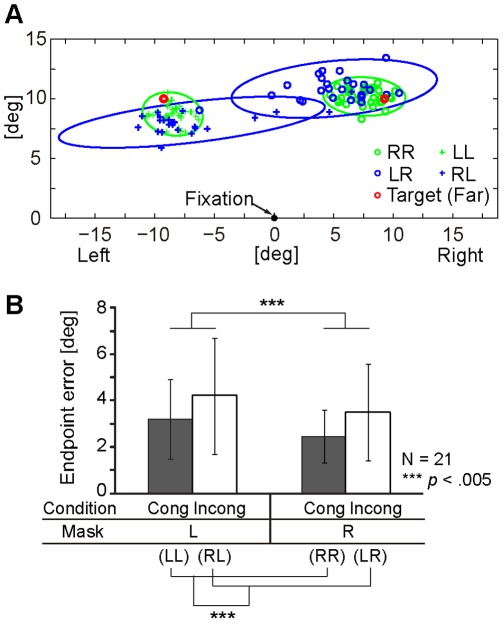
Endpoint error induced by implicit motor control.(A) Endpoint distribution of a single participant and its 95% confidence ellipse in each condition of the far target. Green open circles and crosses respectively denote RR and LL (prime-mask congruent) conditions; blue open circles and crosses respectively denote LR and RL (prime-mask incongruent) conditions. Red open circles indicate the locations of target points. (B) Mean endpoint error in each condition. Data from both target positions (i.e., near and far conditions) were pooled. Error bars indicate the SDs of the endpoint errors across participants. Cong and Incong denote congruent-green and incongruent-blue conditions, respectively.